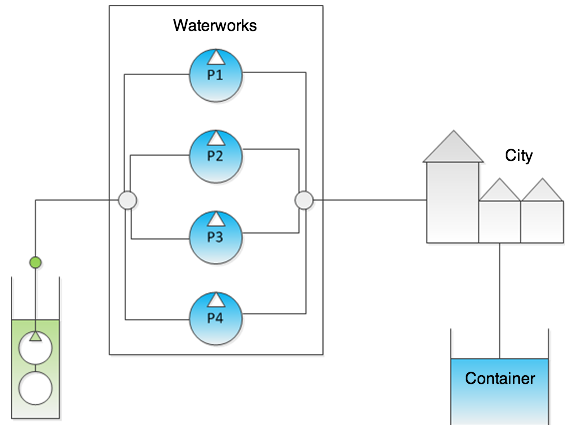
Figure 7. Water supply system with a single water storage container and four pumps.